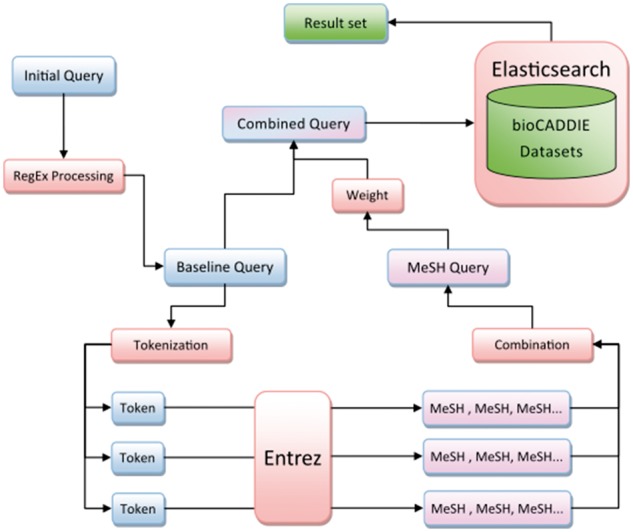
Method overview.